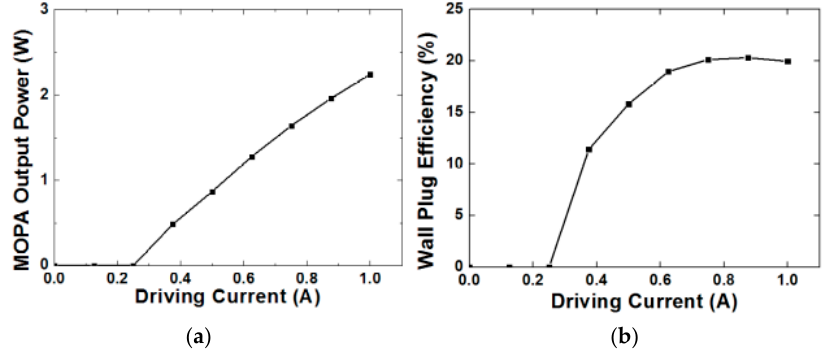
Figure 6. Optical power ( a ) and wall plug efficiency ( b ) of the MOPA system versus driving current.